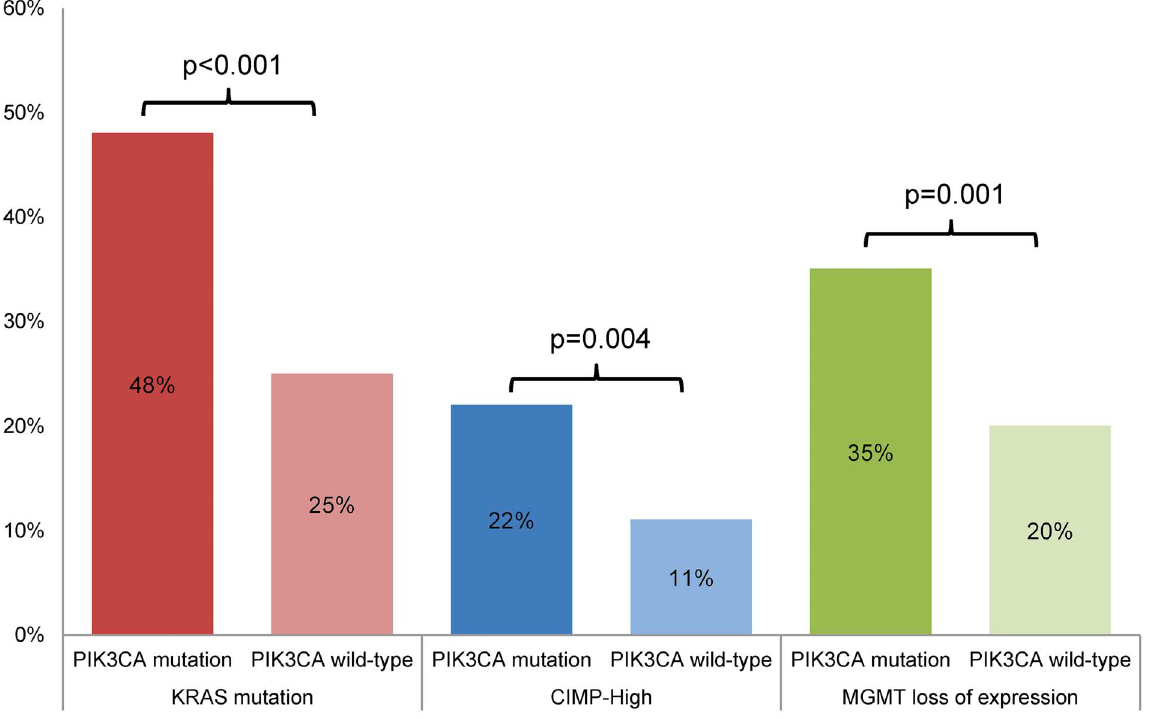
Figure 2. Associations between PIK3CA mutation and KRAS mutation, high levels of CpG island methylator phenotype (CIMP), and loss of MGMT